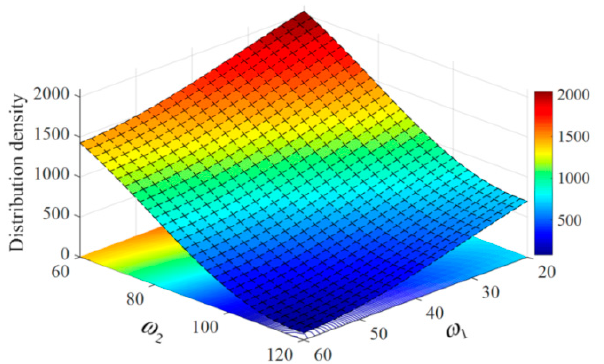
Figure 2. Dynamic dispersion density distribution of warhead fragments.